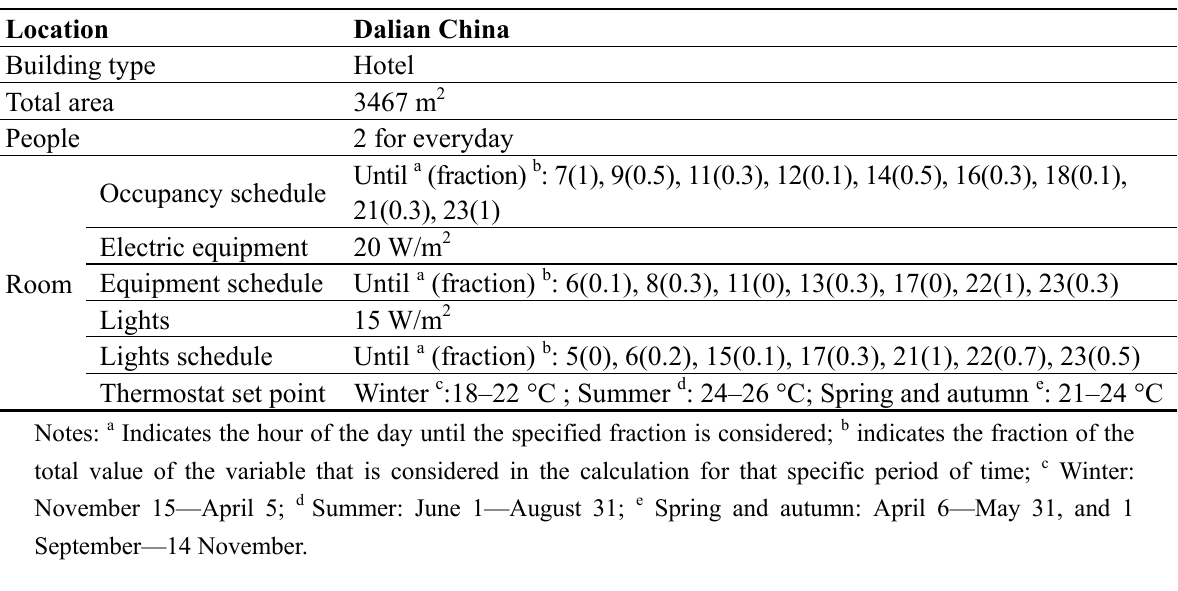
Figure 3. The simulated hourly heating and cooling demand of this hotel based on DeST software.